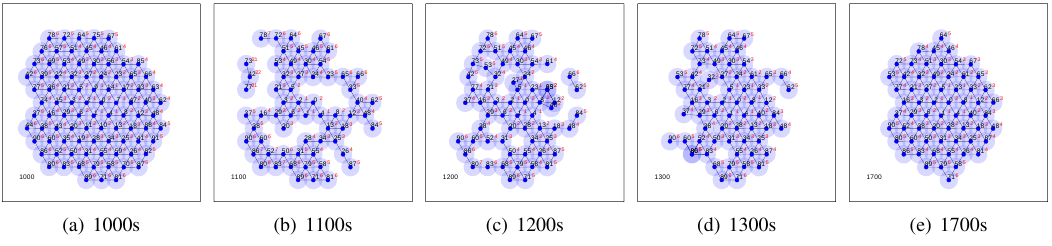
Fig. 6: Deployment snapshots with 30% of node disappearing at 1000s and the self-healing